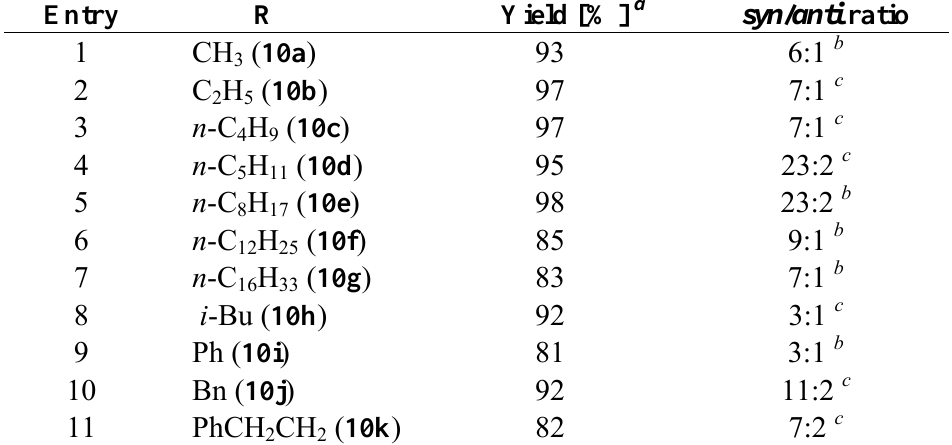
Table 1. Results of reduction according to the procedure shown in Scheme 2